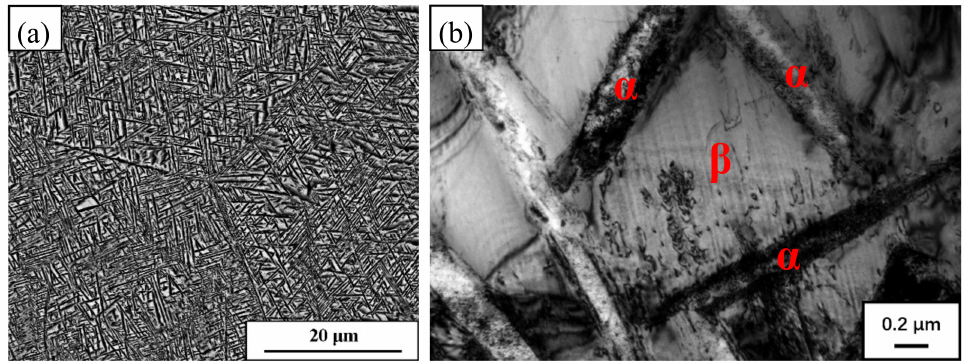
Figure 6. Microstructure of Ti-55531 after compressing to the peak stress at 750 ◦ C/10 − 3 s − 1 (continuous